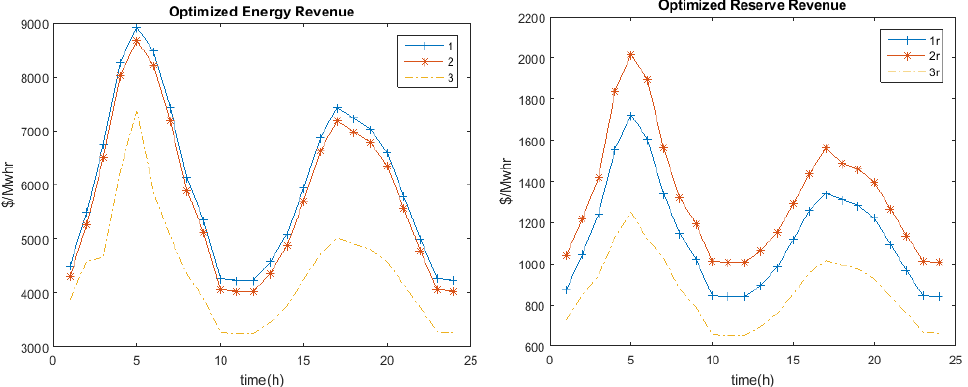
Figure 2. Optimized revenue.